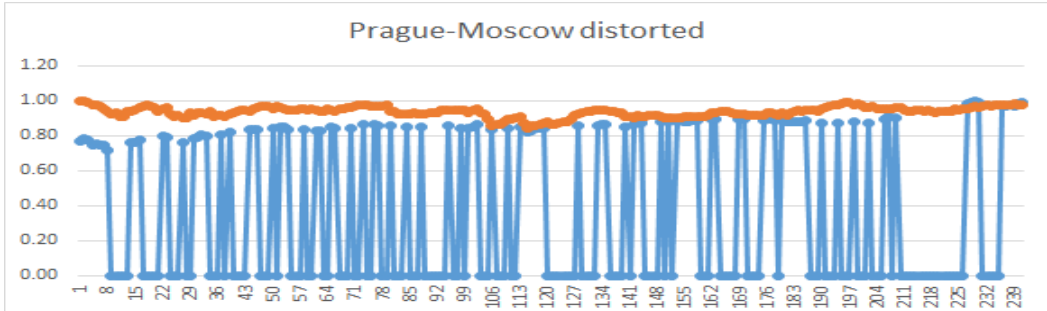
Figure 7. Comparison of graphs of Prague and its artificial inverse stock prices; S ( Prague,Prague inverse ) = 0.34.